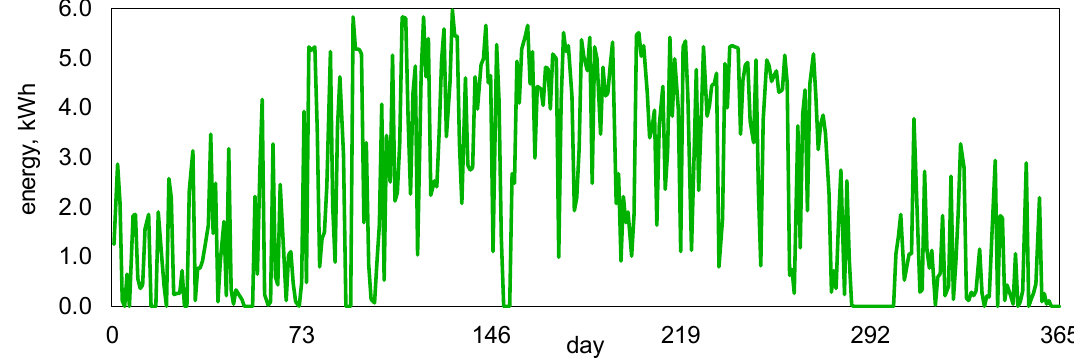
Figure 15. Daily energy generation by 1 kW p PV system (location: 50°17 ′ 36 ″ N 18°40 ′ 55 ″ E; PV panels were positioned 50° to the horizontal and faced 30° southeast (SE)). Data from 2016.